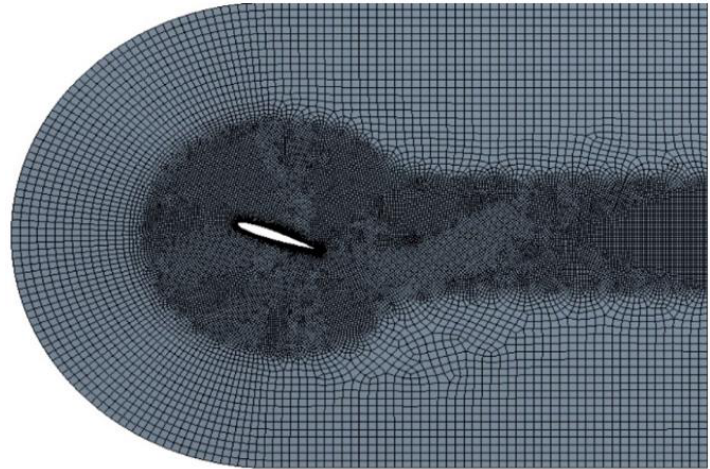
Figure 8. Example 2: Mesh of flow around an airfoil (NACA0012).